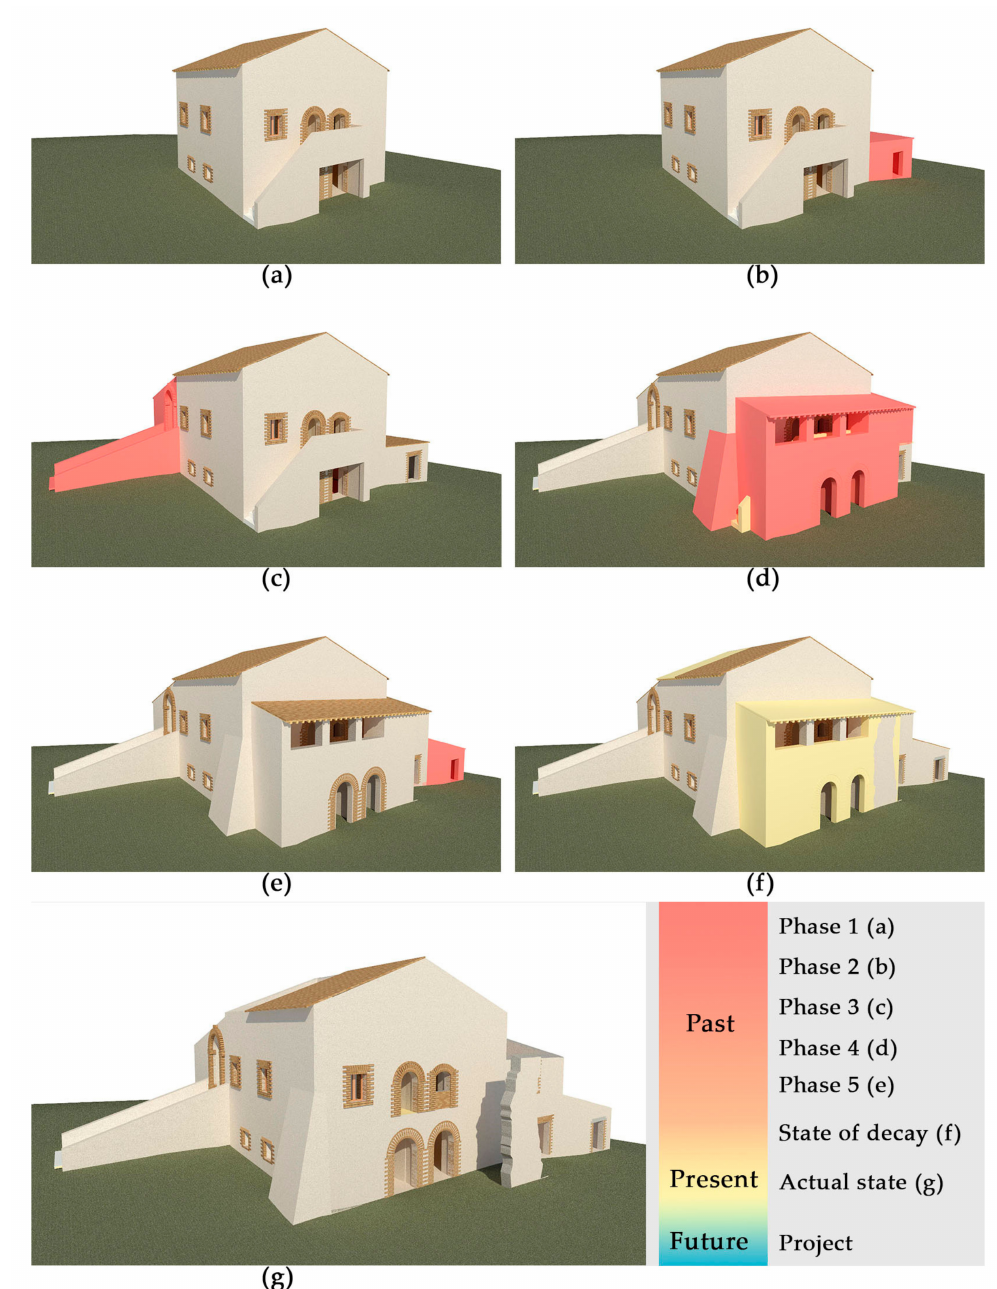
Figure 9. The historical evolution of the building is made explicit through the overwriting of the temporal phases of the model; each subsequent phase keeps a memory of the previous state and highlights the change. ( a – e ) Evolutionary phases of the building over time, and ( f ) representation of the hypothesized parts that, through on/off filter parameters, allow to visualize the actual state ( g ). ( g ) It is starting from the latter model that the designer, in a future time phase, proposes design solutions aimed at restoring the